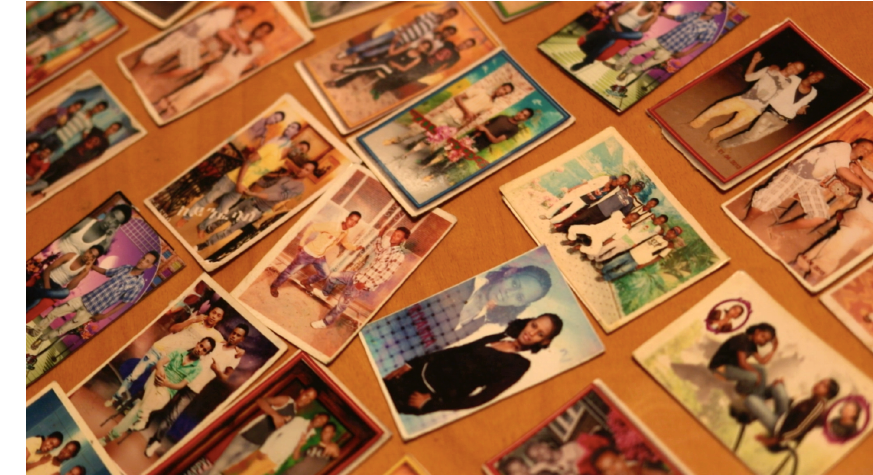
Figure 21. Mhretab’s pictures from Eritrea and Sudan of his family, friends and girlfriends. March 2017.